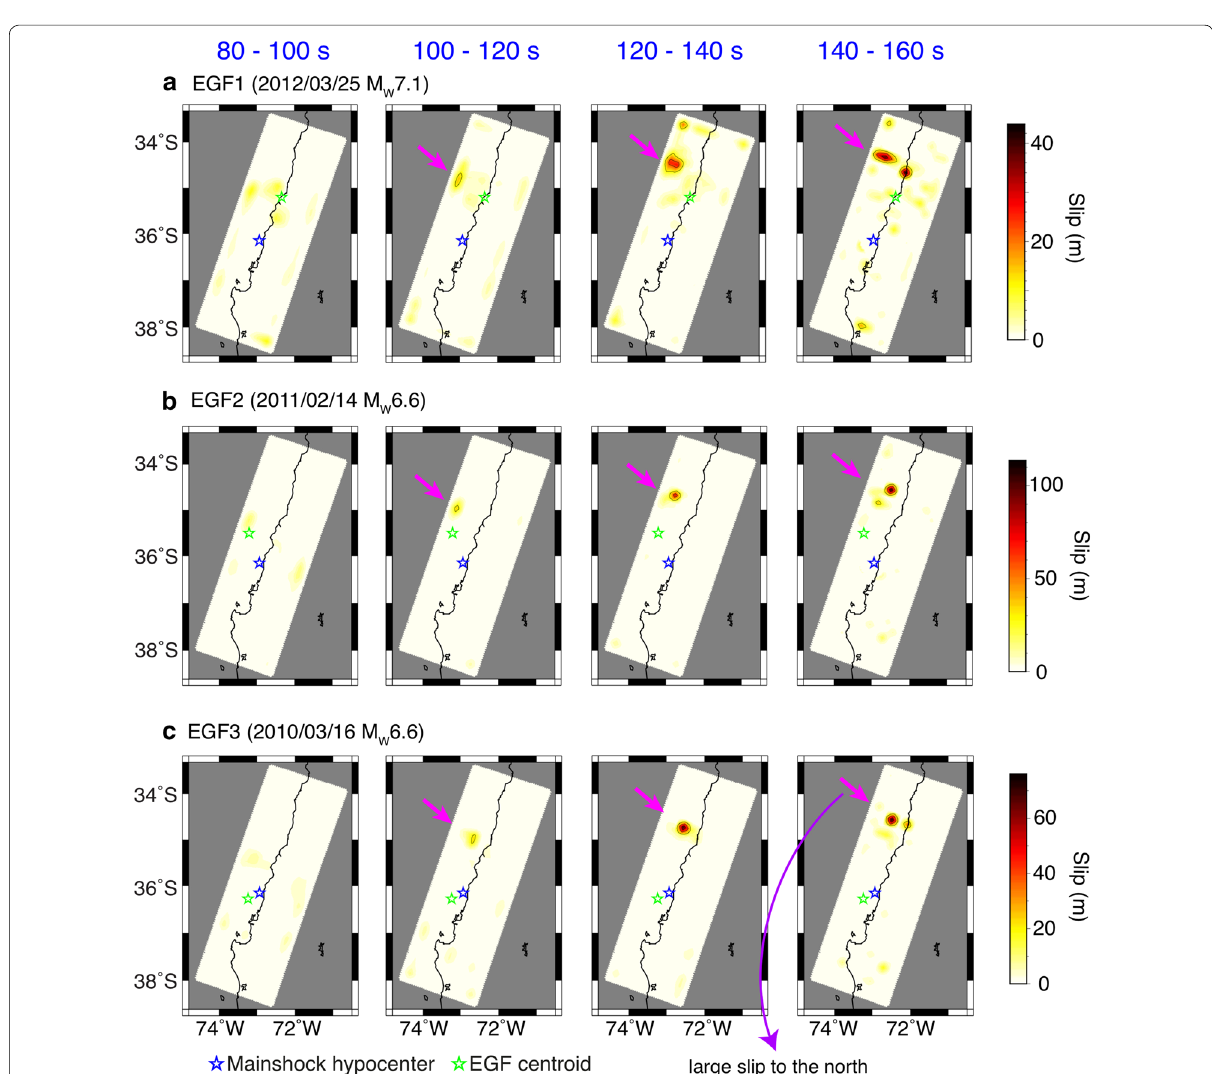
Fig. 6 Comparison of the spatiotemporal slip distribution using different EGFs for the Maule Earthquake. As in Fig. 3, but for the latter portions of the spatiotemporal slip distributions for the Maule Earthquake using a EGF1 (25 Mar 2012, M W 7.1 ), b EGF2 (14 Feb 2011, M W 6.6 ), and c EGF3 (16 Mar 2010, M W 6.6 ). Pink arrows indicate notable slip features to the north (see “The 2010 M W 8.8 Maule Earthquake” section for further